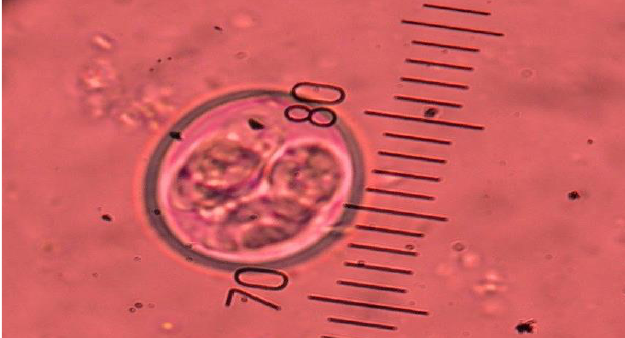
Figure 4. Sporulated Eimeria intricata oocyst by is seen using method of floatation with Sheather's solution (40×)